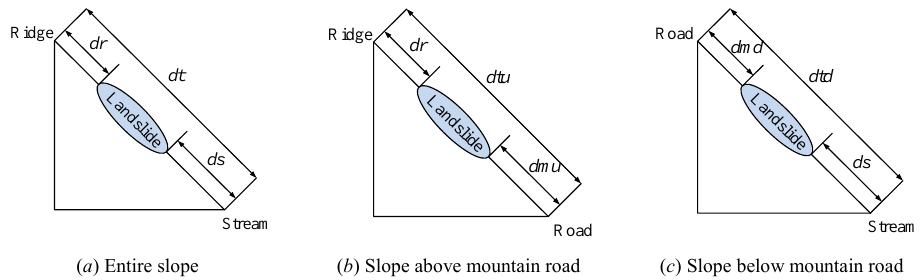
Figure 7: Diagrams of Landslide Area on Slope, in which dr represents the distance between the highest point of a landslide area and the nearest ridge, ds the distance between the lowest point of the landslide area and the nearest stream, and dt the distance between ridge and stream.